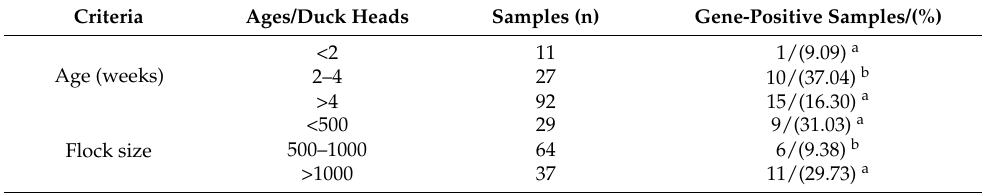
Table 4. Detection of waterfowl parvovirus genome in field duck samples by age and flock